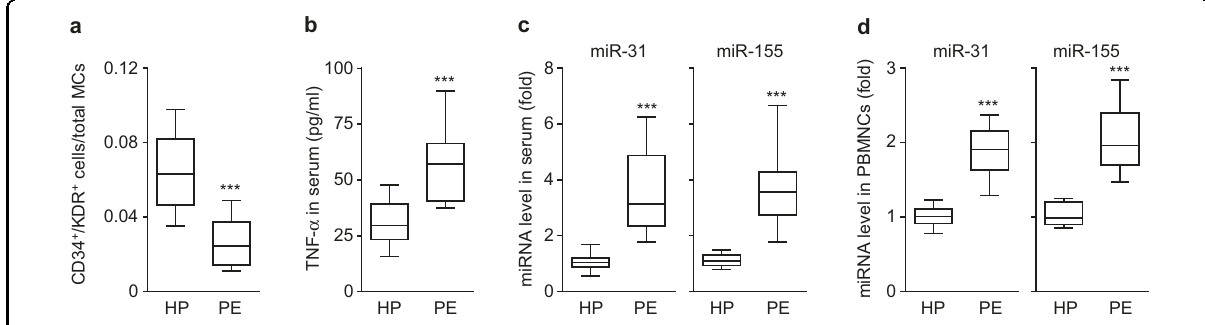
Fig. 1 EPC, TNF- α , miR-31, and miR-155 levels in healthy pregnant women and preeclamptic patients. a The levels of circulating CD34 + /KDR + EPCs in peripheral blood from healthy pregnant (HP) and preeclamptic women (PE). b , c The levels of TNF- α , miR-31, and miR-155 in serum from healthy controls and preeclamptic women. d The levels of miR-31 and miR-155 in PBMNCs from healthy and preeclamptic subjects. n = 12 per group, *** P